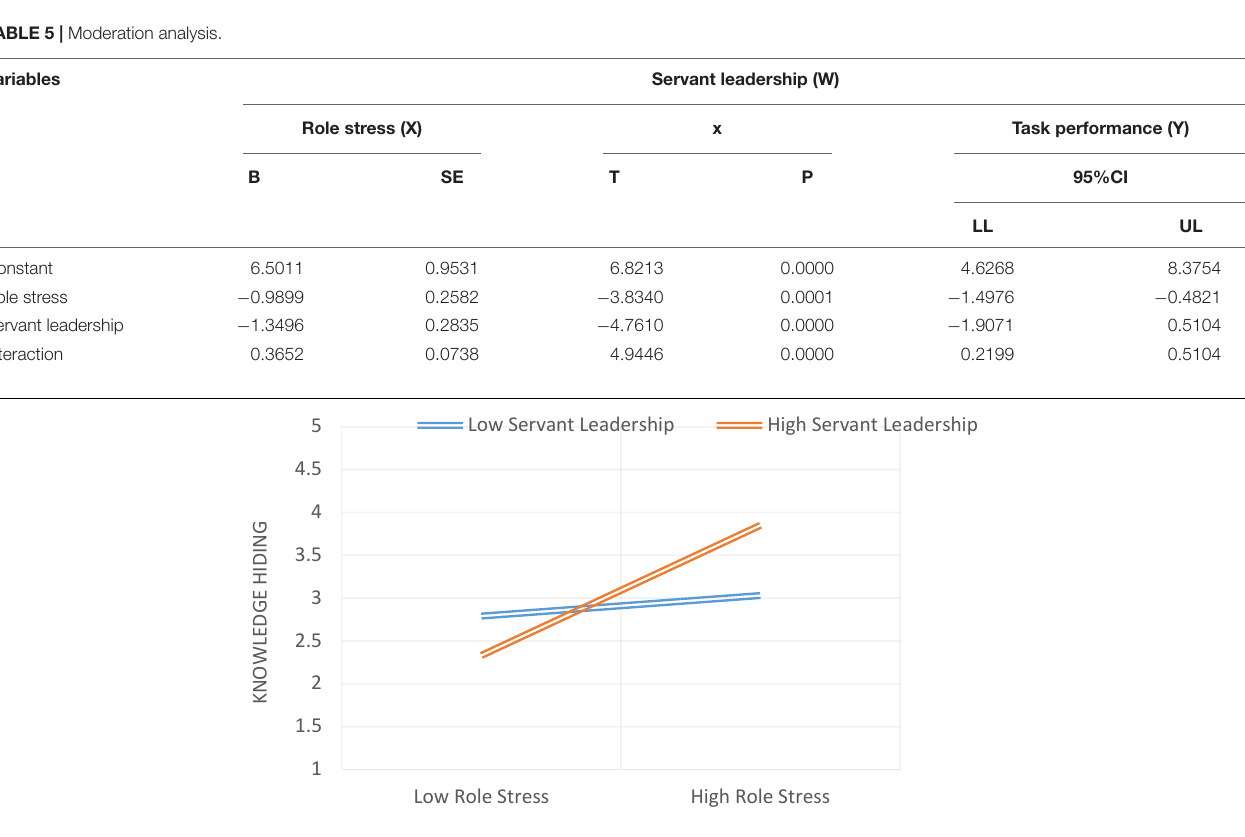
FIGURE 2 | The moderating role of servant leadership between role stress and Knowledge hiding. TABLE 6 | Moderation